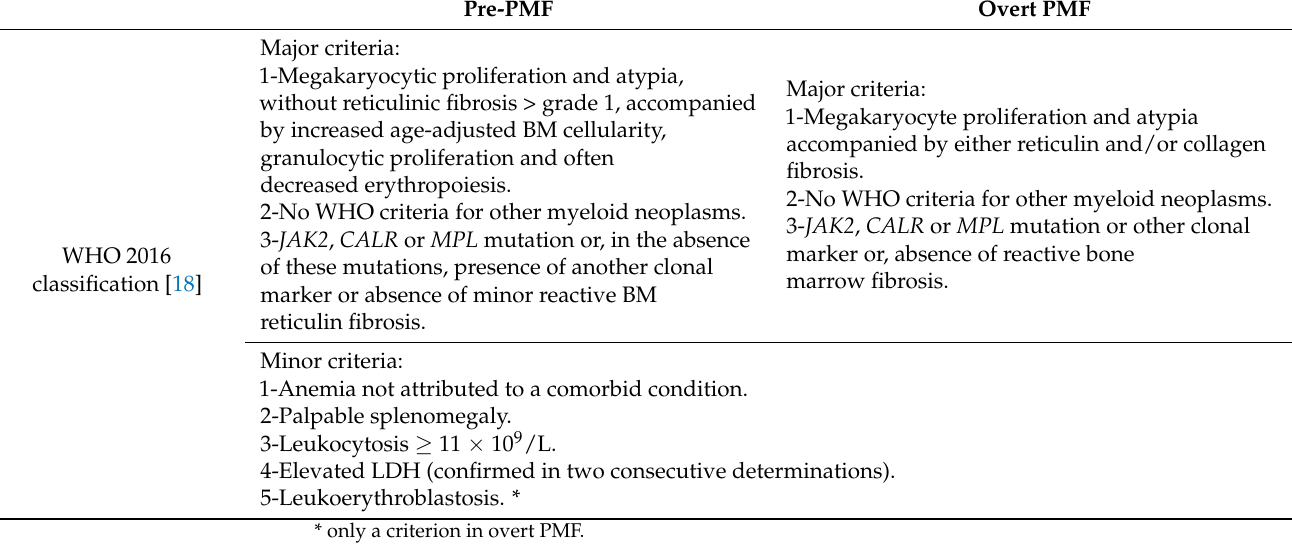
Table 4. Classification criteria for pre-PMF and PMF diagnosis.